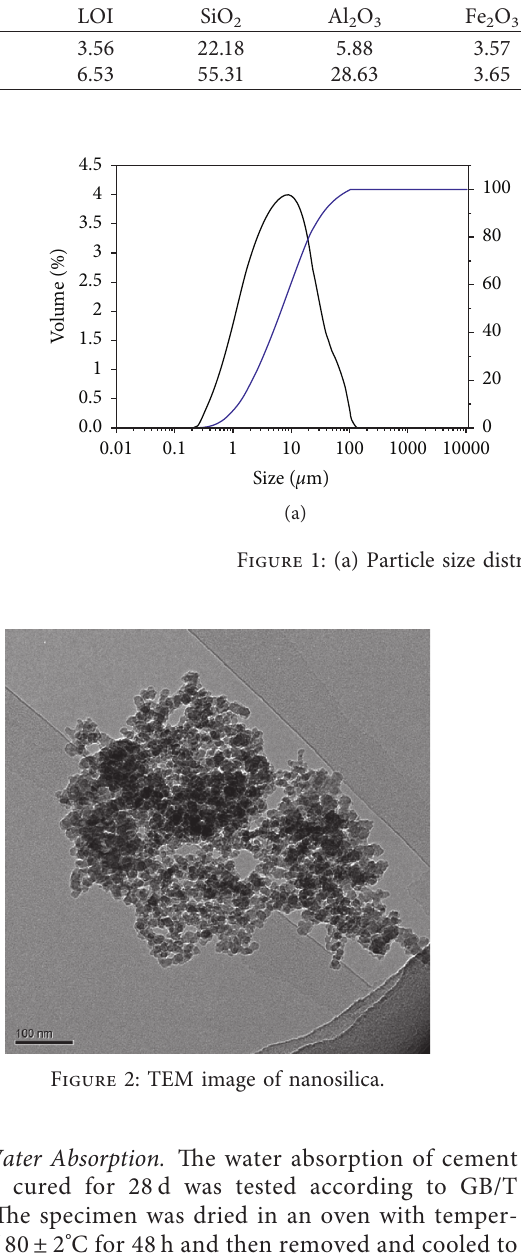
Table 1: Chemical composition of cement and fly ash/wt.%.